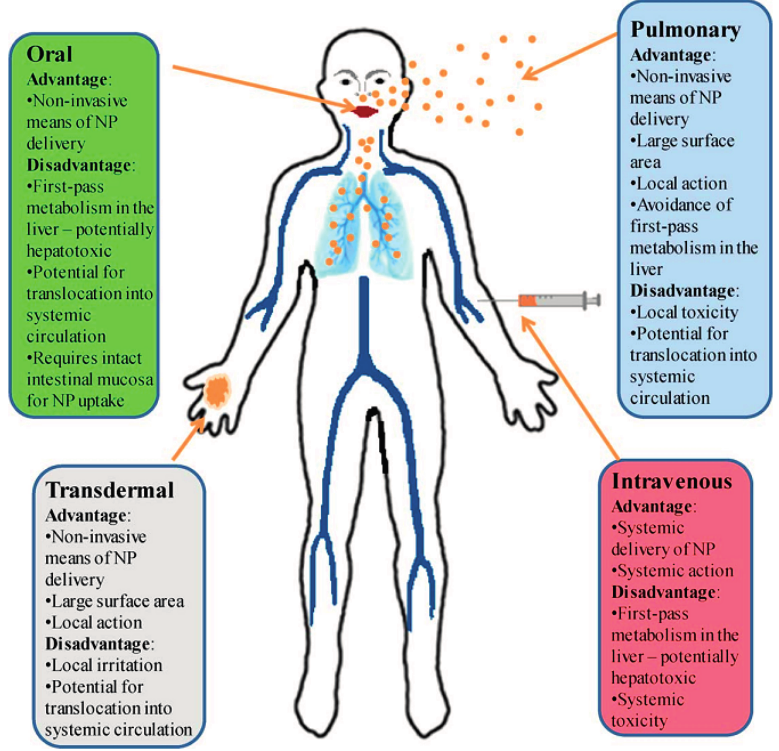
Figure 9. Nanoparticle administration paths and their advantages and disadvantages